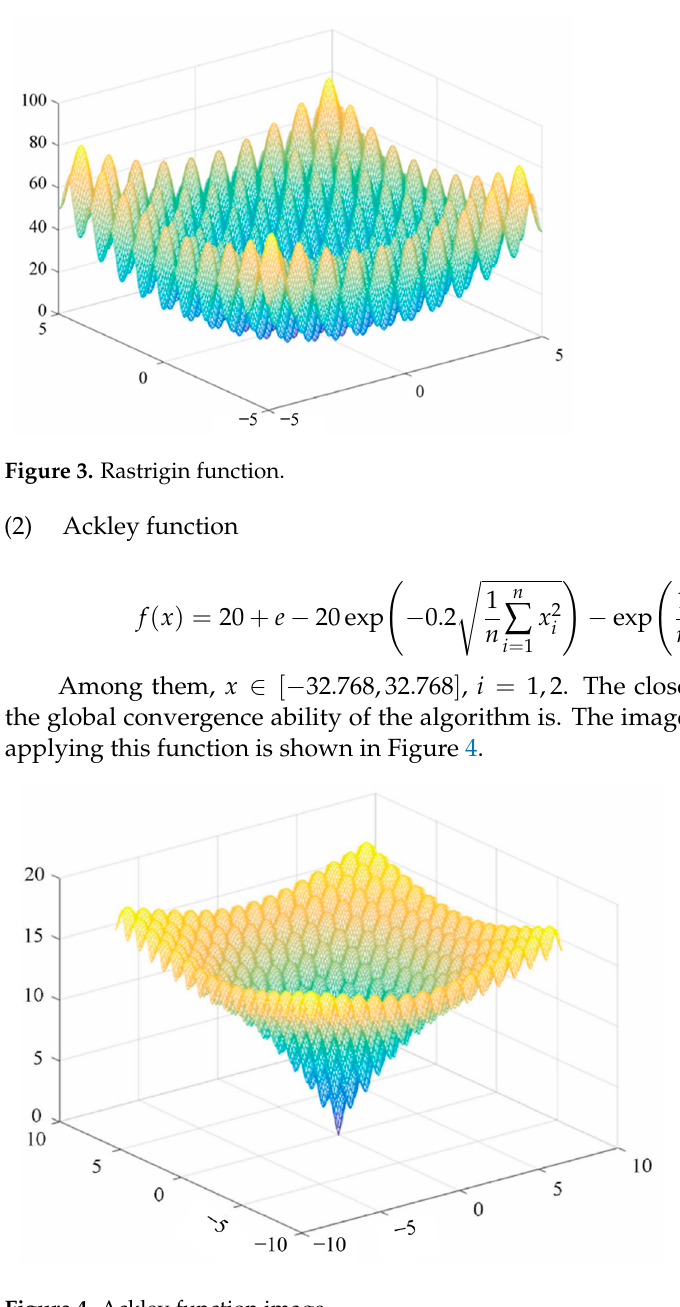
Table 1. Test function results.